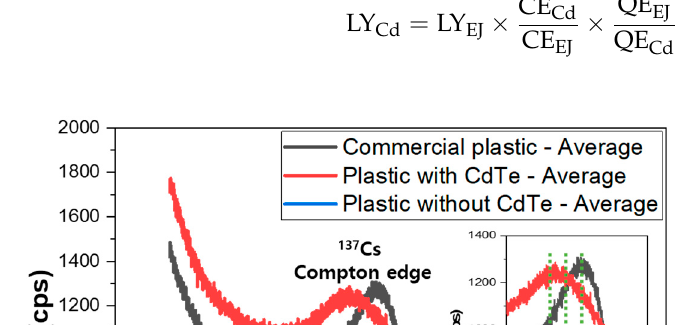
Table 3. Compared relative light yield by distance to Cs-137 gamma ray